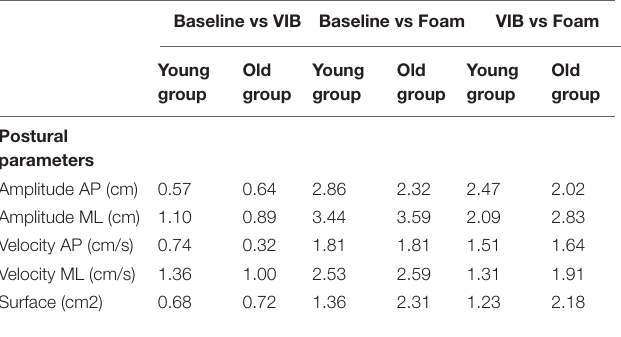
TABLE 3 | Effect sizes (Cohen’s D) between different conditions for each group in all postural